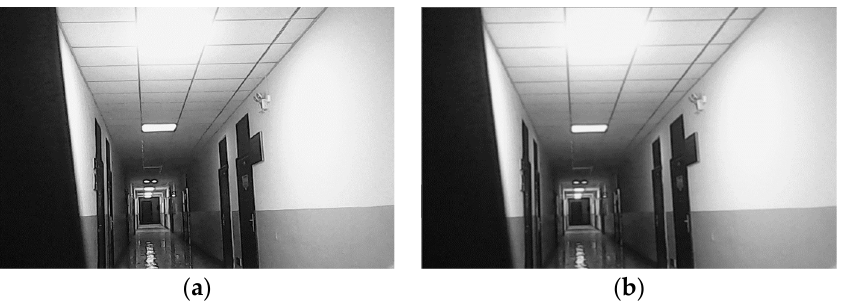
Figure 3. Before and after Gaussian filtering comparison. ( a ) Before Gaussian filtering; ( b ) after Gaussian filtering.